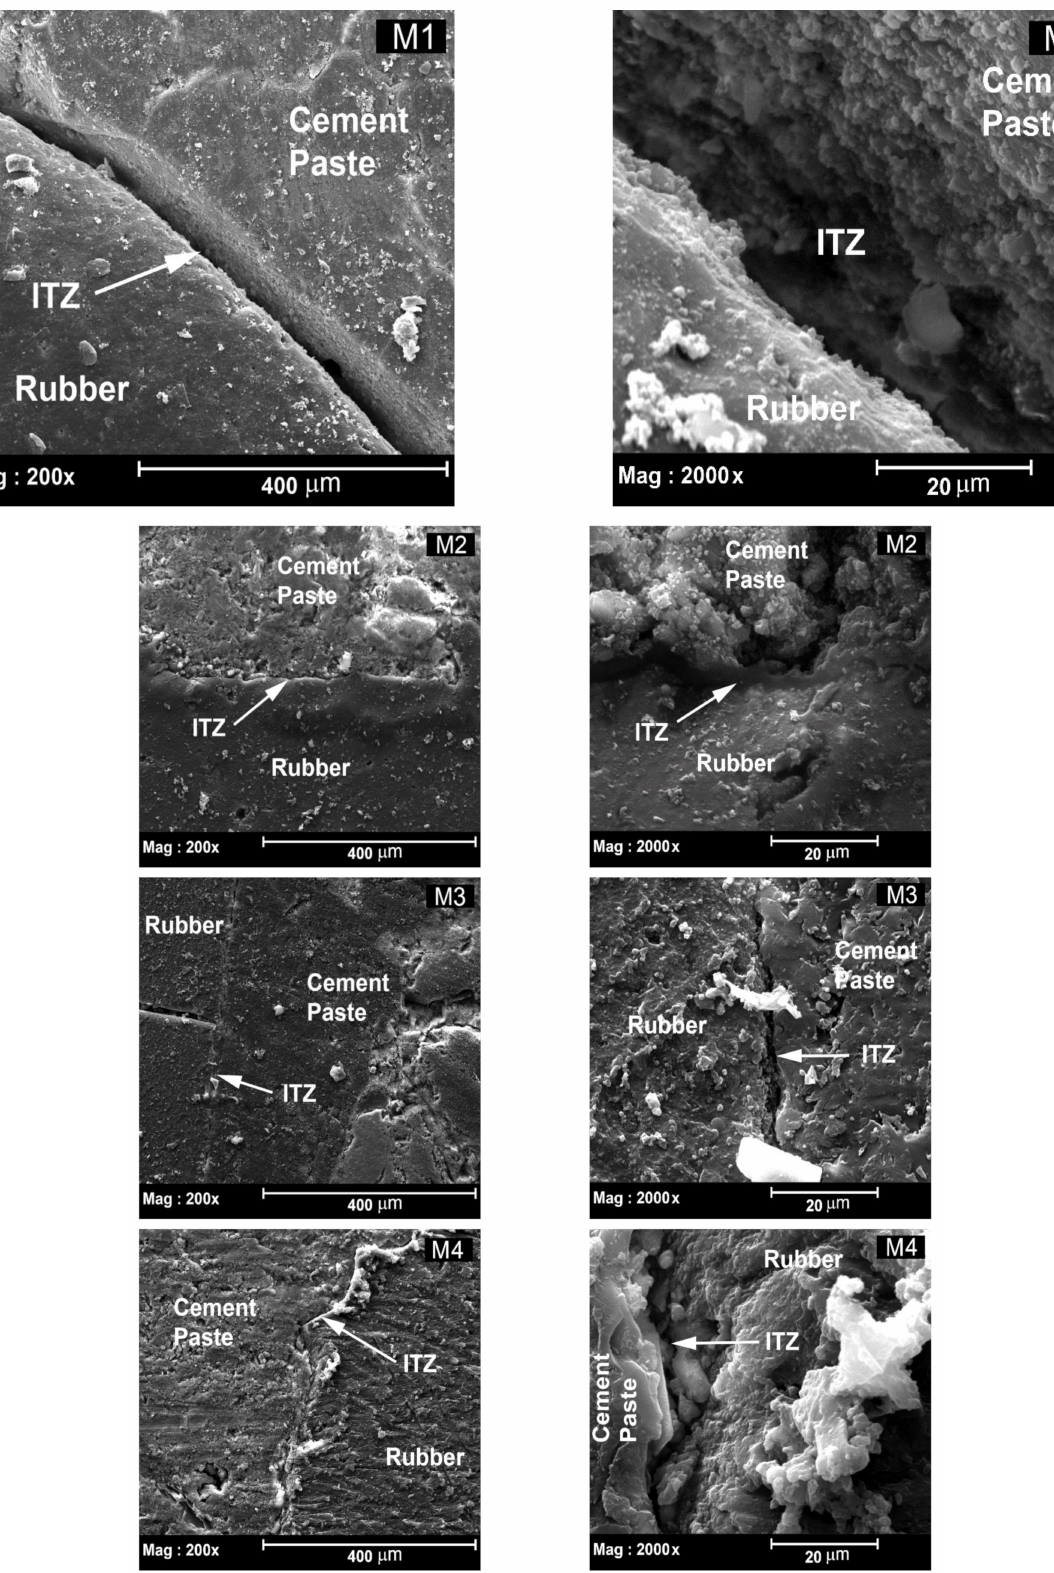
Figure 8. SEM images of hardened mortar samples at 28 days of